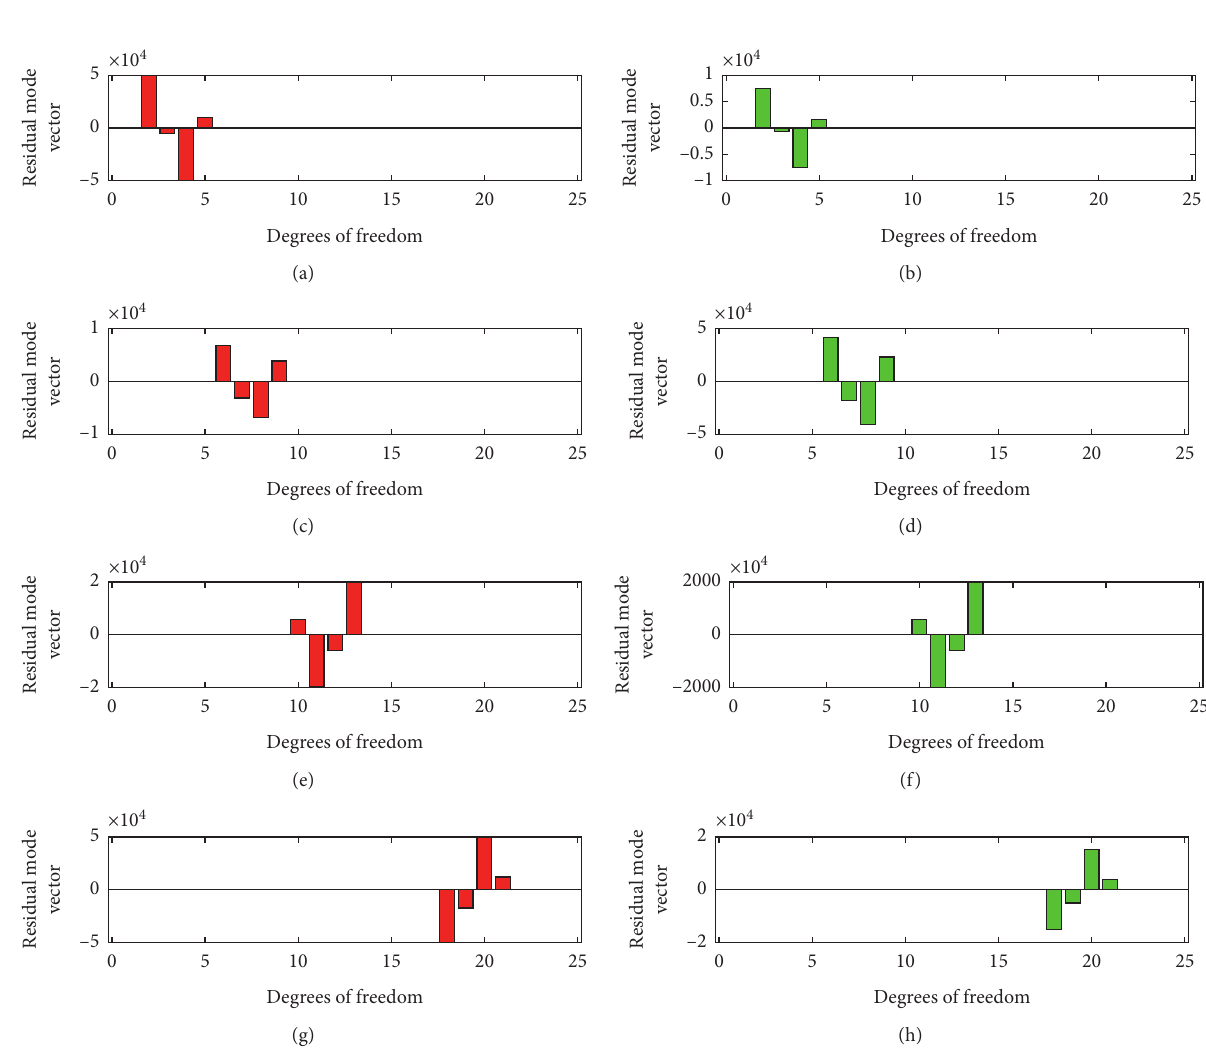
Figure 5: Residual mode vector according to damage location. Table 2: The evaluated damage